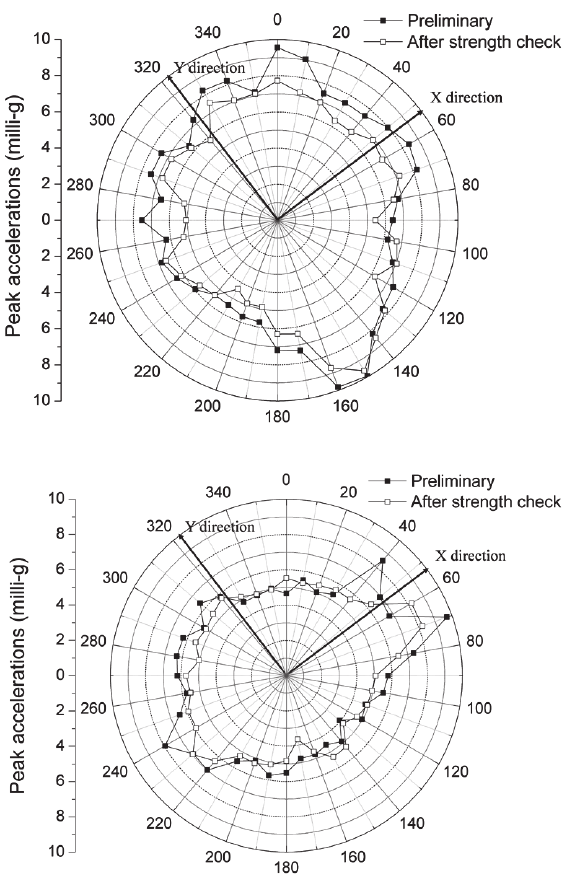
Fig. 9. Peak accelerations according to the wind